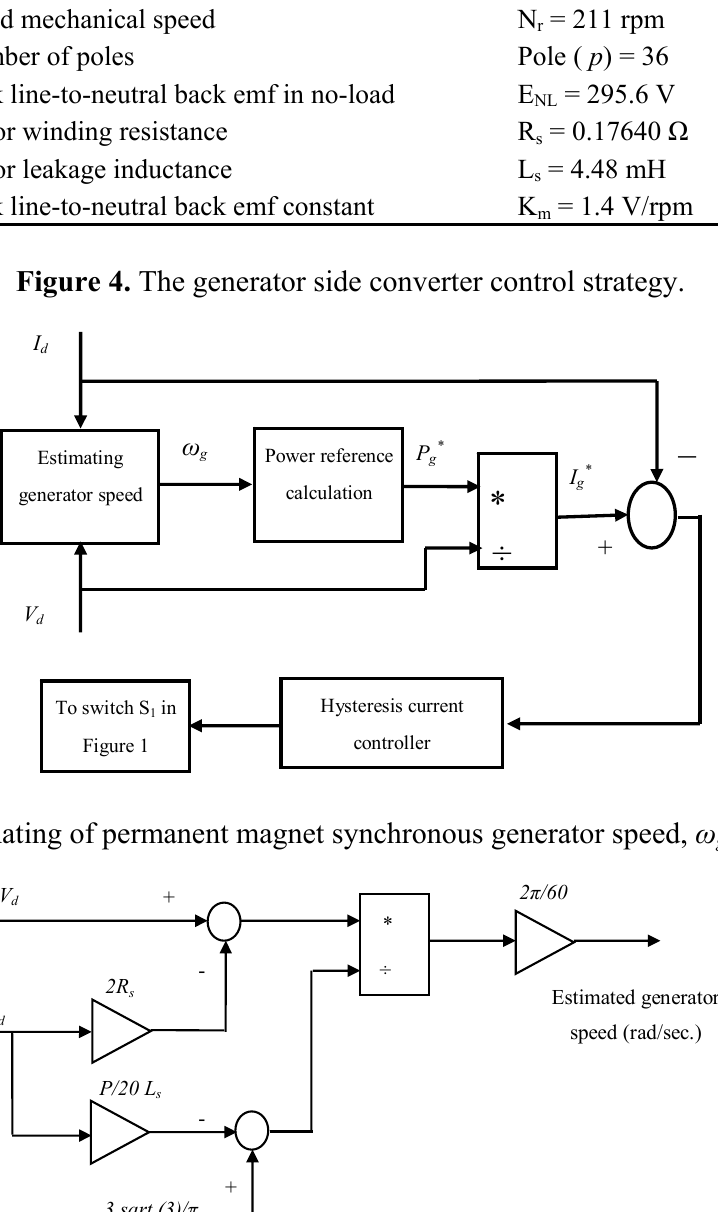
Table 1. Parameters of permanent magnet synchronous generator.